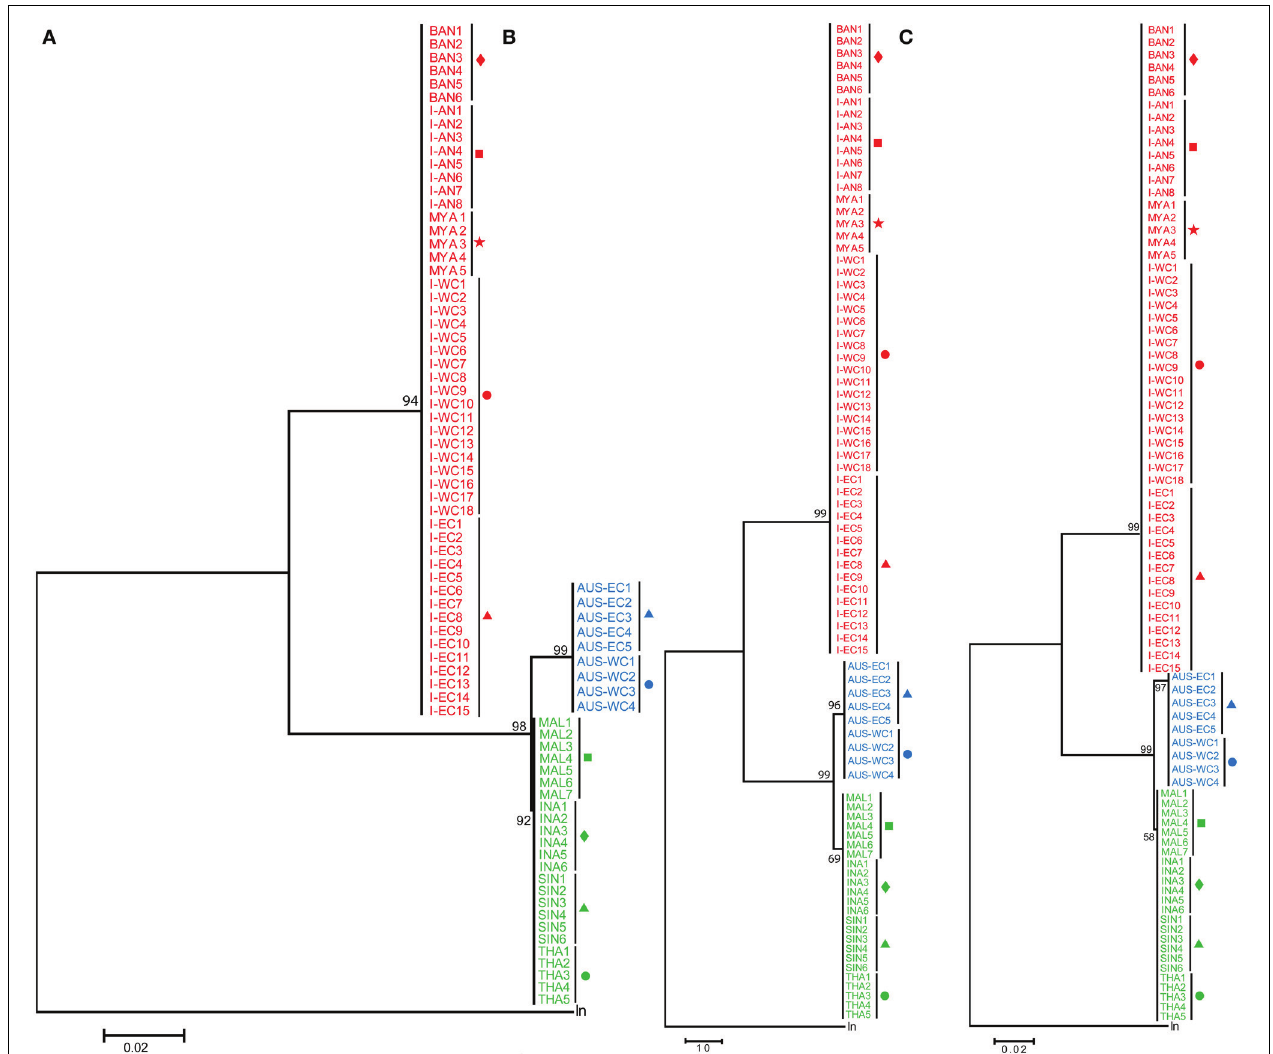
FIGURE 3 | Phylogenetic analyses based on COI sequences. COI sequences from India-Western Coast (I-WC), India-Eastern Coast (I-EC), India-Andaman and Nicobar Islands (I-AN), Bangladesh (BAN), Singapore (SIN), Indonesia (INA), Malaysia (MAL), Thailand (THA), Myanmar (MYA), Australia-Western Australia (AUS-WC), and Australia-Queensland (AUS-EC) were used for Maximum likelihood (ML) (A) , Maximum Parsimony (MP)